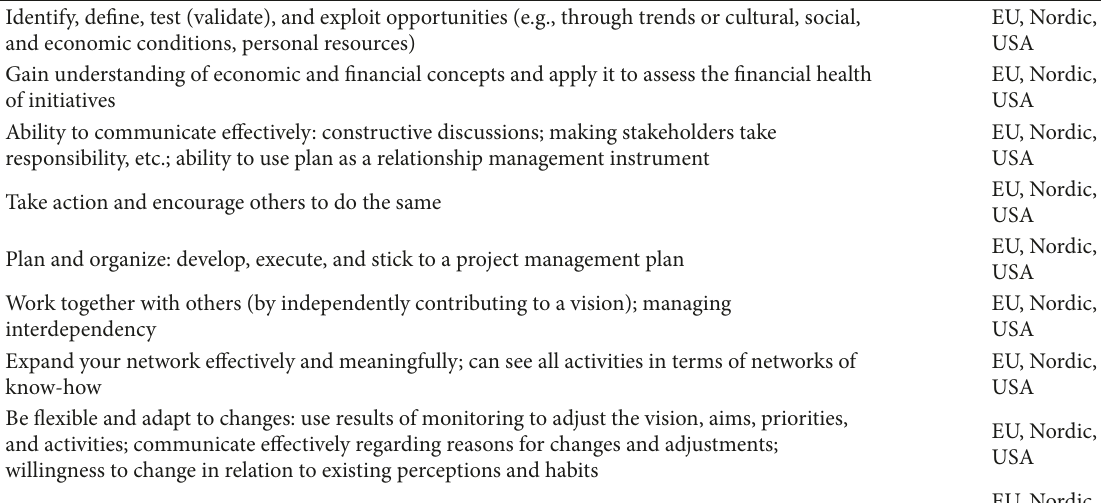
Table 5: Categorization of common and differing competencies between all five observed EE competence models.